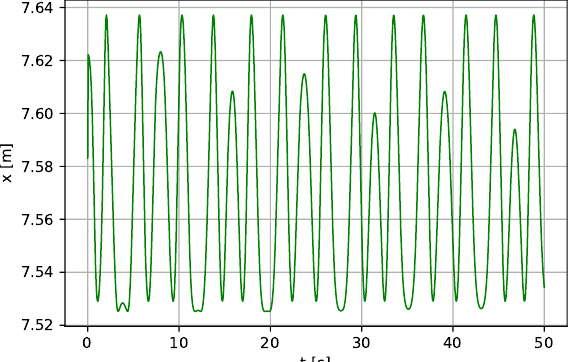
Figure 23. Linear displacement x pc ( t ) of the piston (Case II—a variable length concept of the pendulum pump) for c p = 1 N